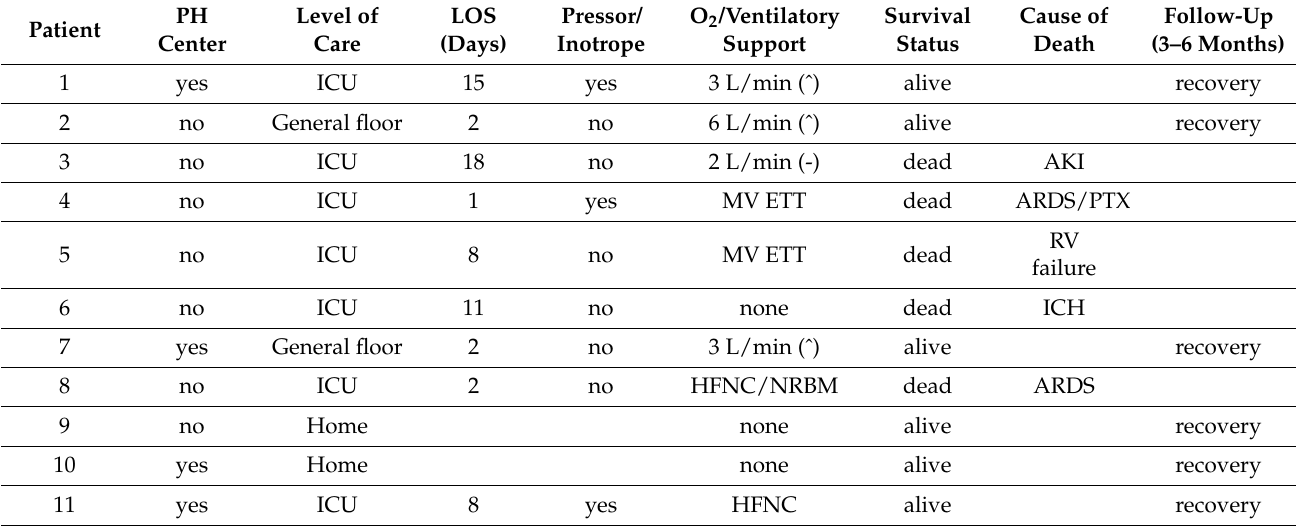
Table 5. Hospitalization and outcome